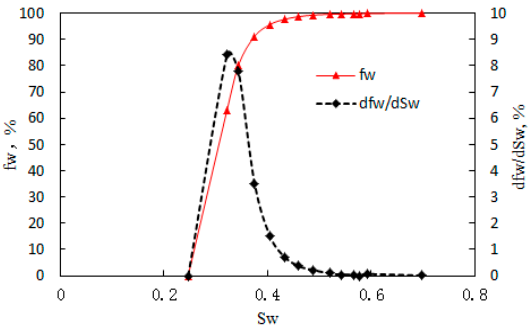
Figure 9. Water-oil relative permeability (upper) and fractional flow (lower) curves. Table 4. Related calculation of the homogeneous core.